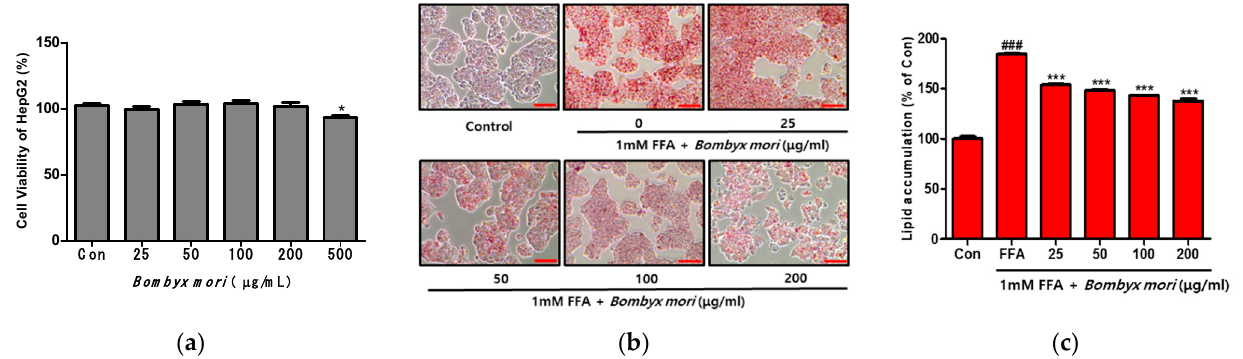
Figure 1. Effects of Bombyx mori (SW) on the viability and intracellular lipid accumulation in FFA-induced HepG2 cells. Lipid droplets in HepG2 cells were dyed red (magnification 200×). ( a ) Cell viability of HepG2 cells. * p < 0.05 vs. Con. ( b ) Oil Red O staining images of HepG2 cells treated with 1 mM free fatty acids (FFA) and exposed to various concentration of SW with 1 mM FFA for 24 h. ( c ) Quantitative lipid accumulation of Oil Red O contents at 500 nm. Control (Con) cells were incubated with 1% fat-free bovine serum albumin. Data represent means ± SD of three independent experiments. ### p < 0.001 vs. Con; *** p < 0.001 vs. FFA.